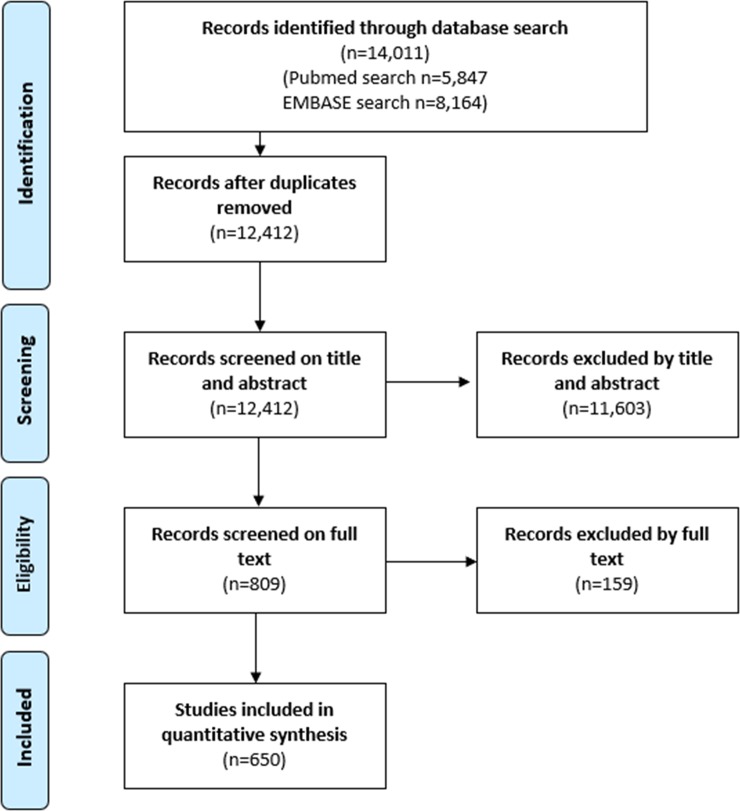
Flowchart diagram.